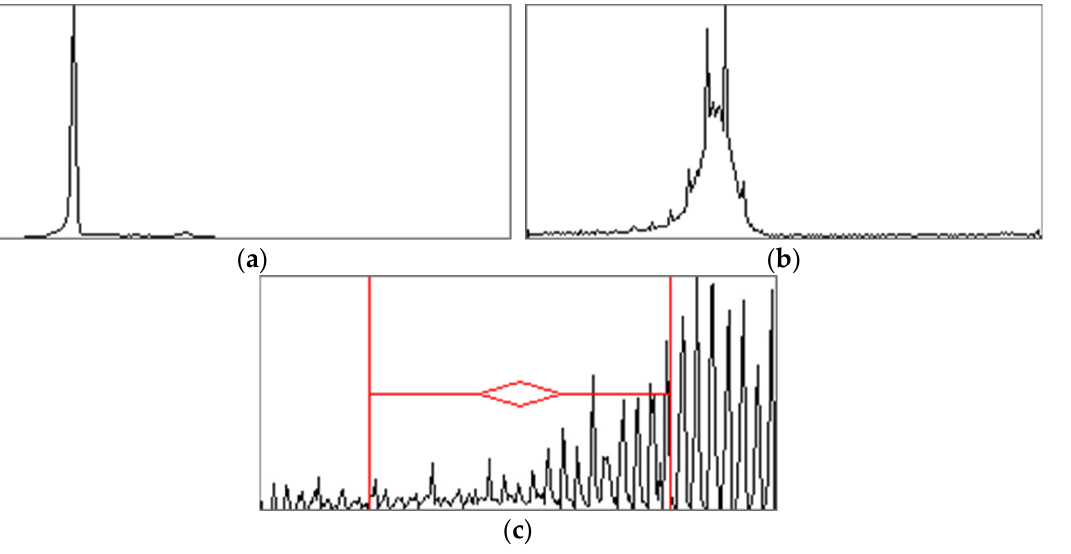
Figure 7. Reflectivity histograms in blue channel for ( a ) the original, Figure 2, ( b ) partially enhanced, Figure 5a, and ( c ) fully enhanced, Figure 6, images. Thresholds of non-opaque mineral segmentation are shown in ( c ).